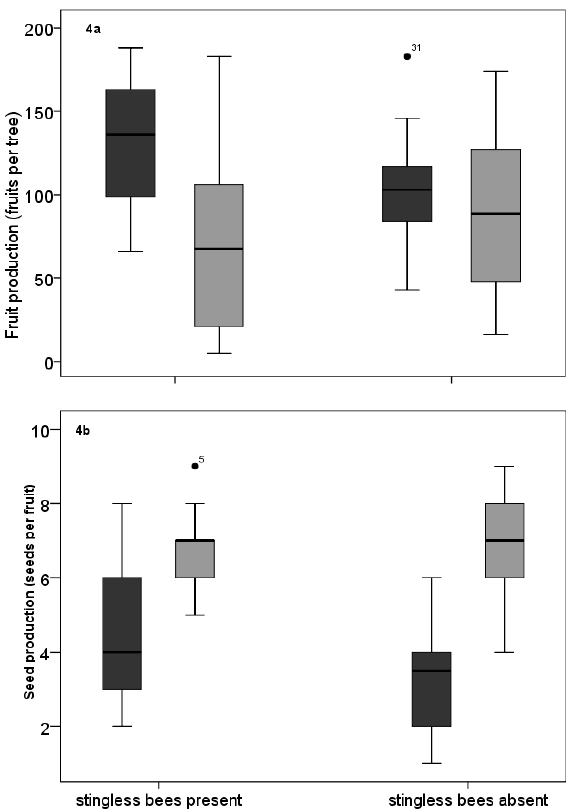
F IGURE 4. Fruit (4a) and seed production (4b) in Eva (dark grey bar) and Princess (light grey bar) apple trees (n = 24 trees for each tested density). The dataset obtained in 2012 was from three parcels densely populated with both stingless bees (n = 12 colonies ha -1 ) and Africanised honeybees (7 hives ha -1 with pollen collectors) and three parcels populated with Africanised honeybees only (7 hives ha -1 with pollen